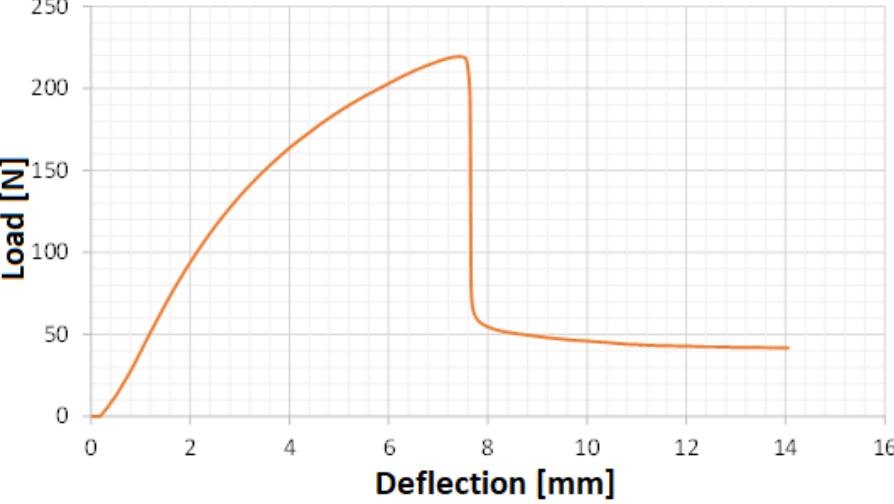
Figure 8. Load vs. mid-span deflection measured during sample c2 testing.